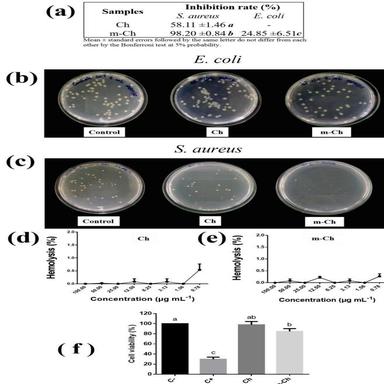
(a) The antimicrobial effect of Ch and m-Ch in percentage. (b) The effect of solution containing different materials on the antimicrobial activity against E. coli and (c) and S. aureus. (d) Cytotoxic effects of Ch (e) m-Ch with sheep's erythrocytes (f) cellular viability of Ch and m-Ch in human fibroblast.